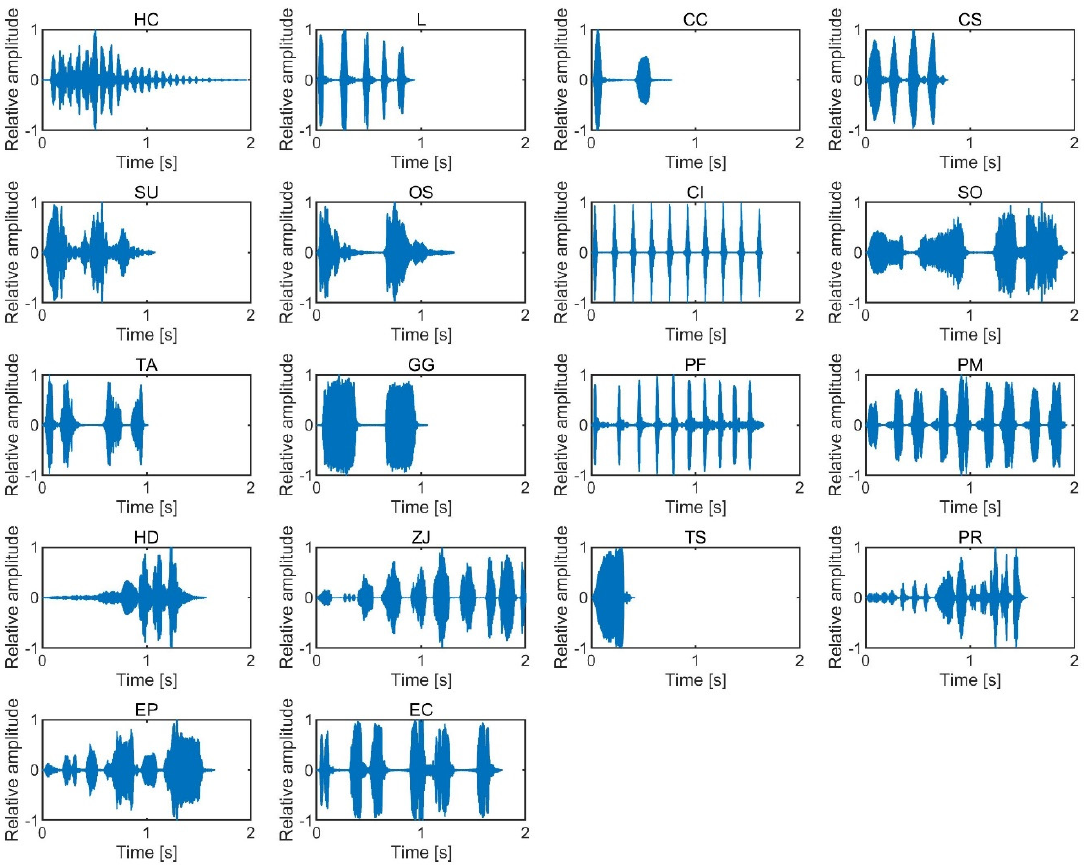
Figure 1. Temporal waveforms of the 18 birdsongs.